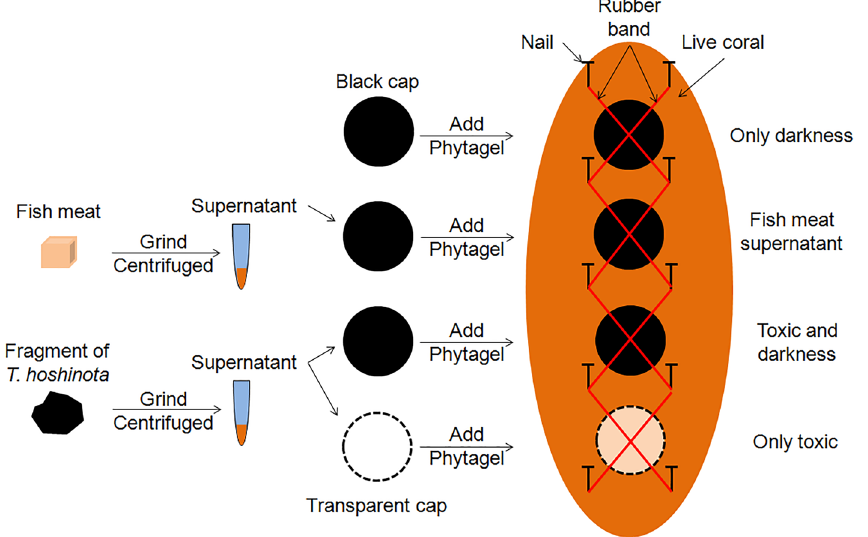
Figure 10. The design of sponge supernatant